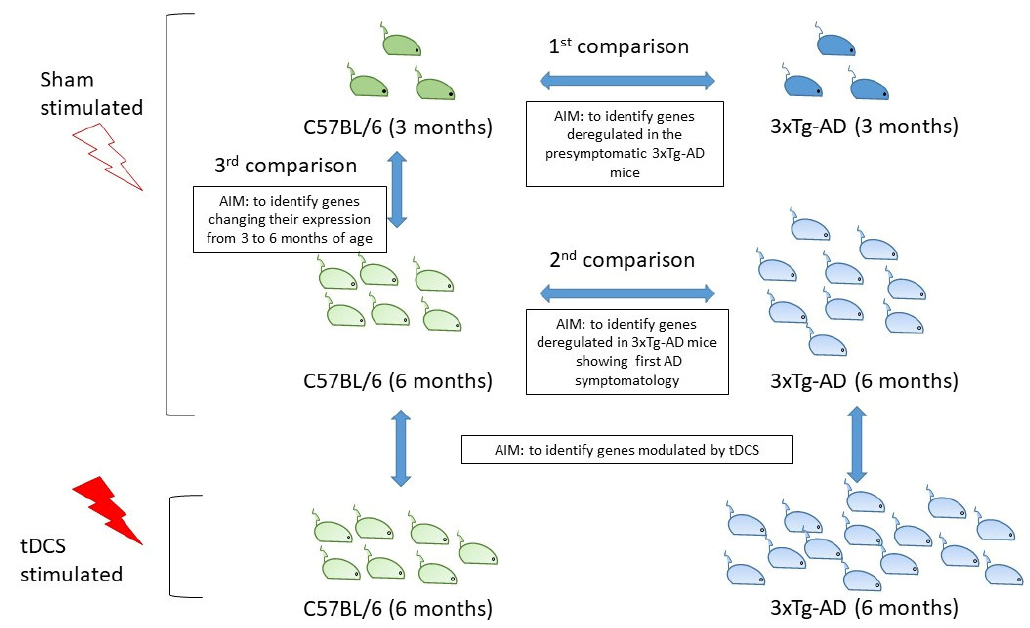
Figure 1. Study design.